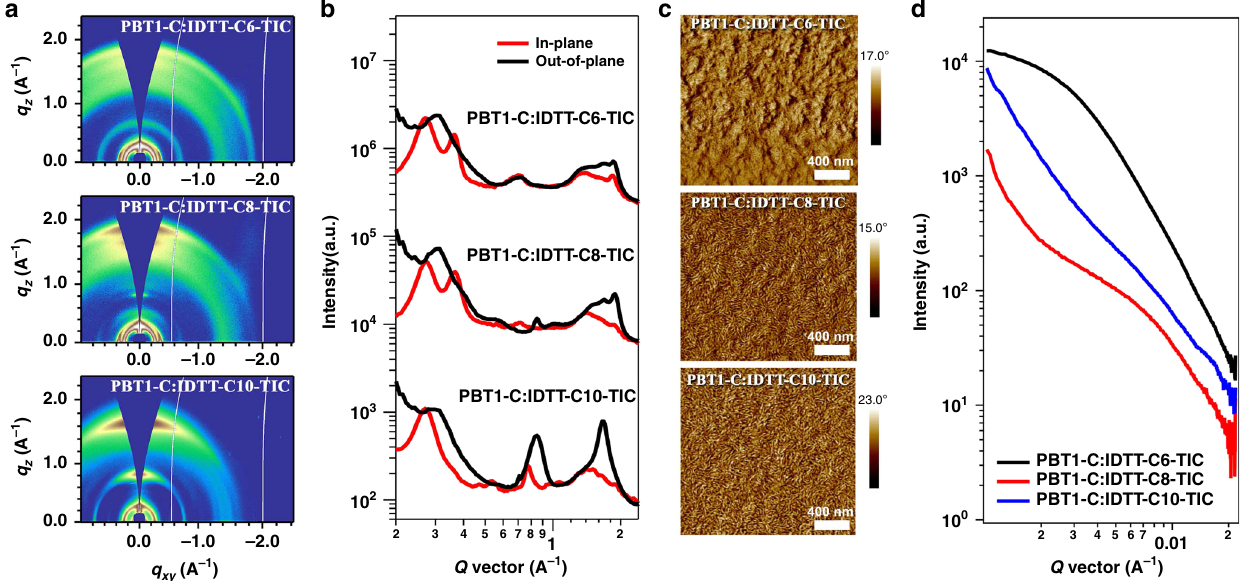
Fig. 3 Morphology characterizations. a GIWAXS diffraction patterns of PBT1-C:IDTT-CX-TIC blends and ( b ) the corresponding in-plane and out-of-plane line-cut pro fi les. c AFM phase images of PBT1-C:IDTT-CX-TIC blends (2 × 2 μ m). d RSoXS scattering pro fi les of PBT1-C:IDTT-CX-TIC blends.